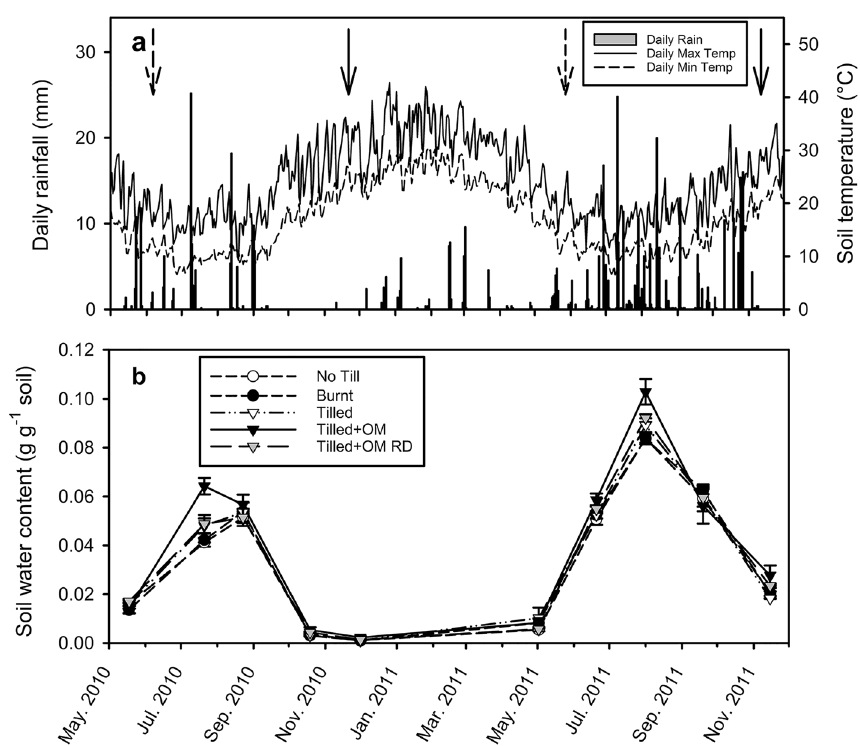
Figure 1. ( a ) Daily rainfall (bar graph, left y-axis) and daily soil minimum and maximum temperature at 5 cm depth (line graph, right y-axis) measured at the study site. ( b ) Soil water content (0–10 cm) at time of soil sample collection. Soil water content values are a mean of three field replicates, error bars are ± standard error of the mean. Dashed arrows indicate date of seeding (wheat, Triticum aestivum ) and solid arrows indicate date of harvest. Nitrogen fertilizer was applied at seeding (28th May 2010 and 1st June 2011) and at crop emergence (12th July 2010 and 26th July 2011). OM organic matter, RD